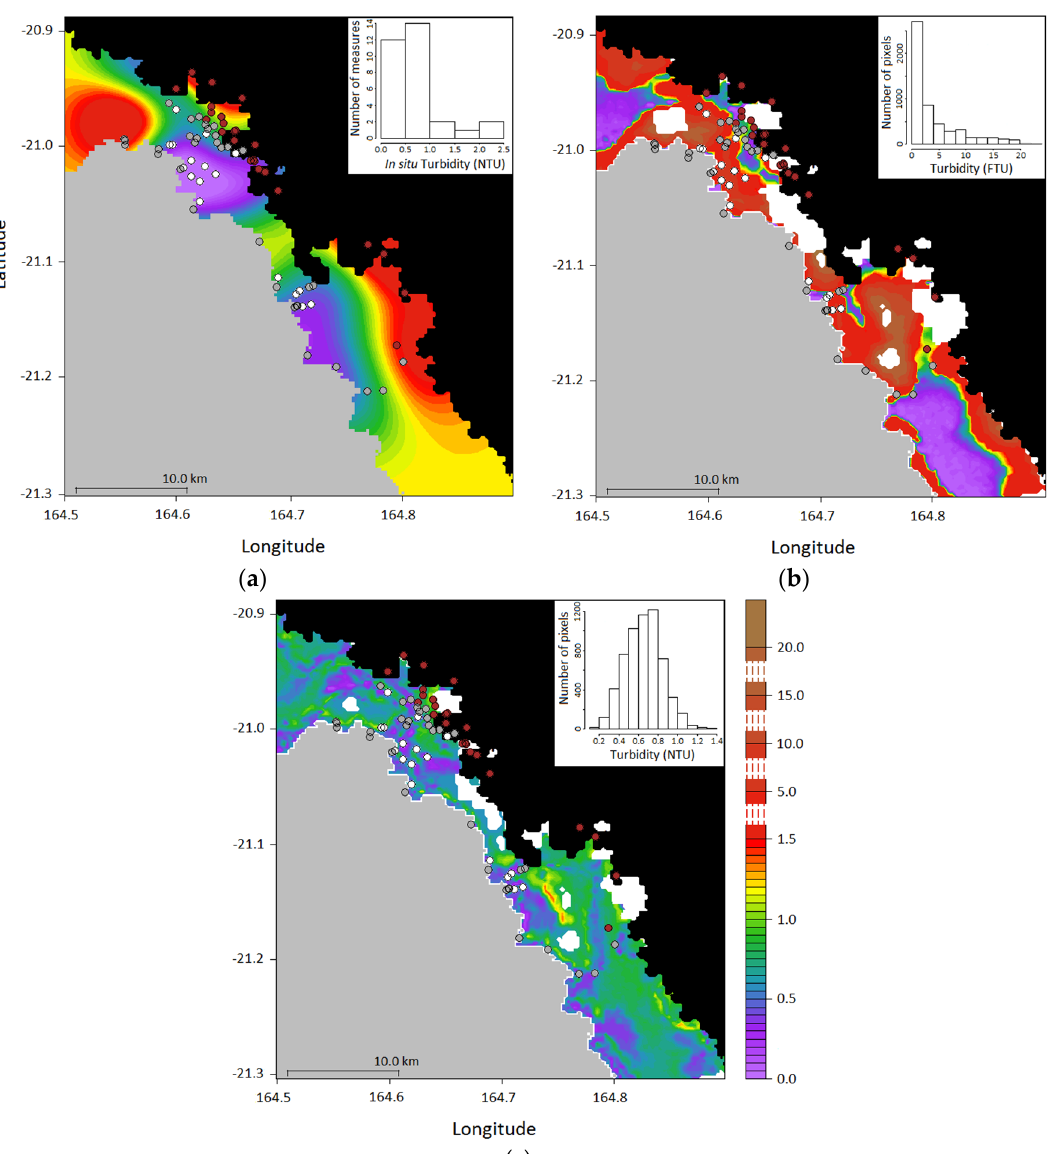
Figure 6. Turbidity in the VKP lagoon area on 21 April 2014. ( a ) in-situ turbidity values (in NTU) interpolated by ordinary kriging and their histogram, as measured with the CTD; ( b ) Map and histogram of turbidity (in FTU) retrieved from the MODIS image with the O2008 model; ( c ) Map and histogram of the turbidity values (in NTU) retrieved from the MODIS image with our B.O.M. Black areas correspond to MODIS land mask and grey areas correspond to deep ocean. Points colours correspond to bottom colour, i.e., : white bottom; : grey bottom; : brown bottom. On maps ( b ) and ( c ) the white areas correspond to flagged pixels.